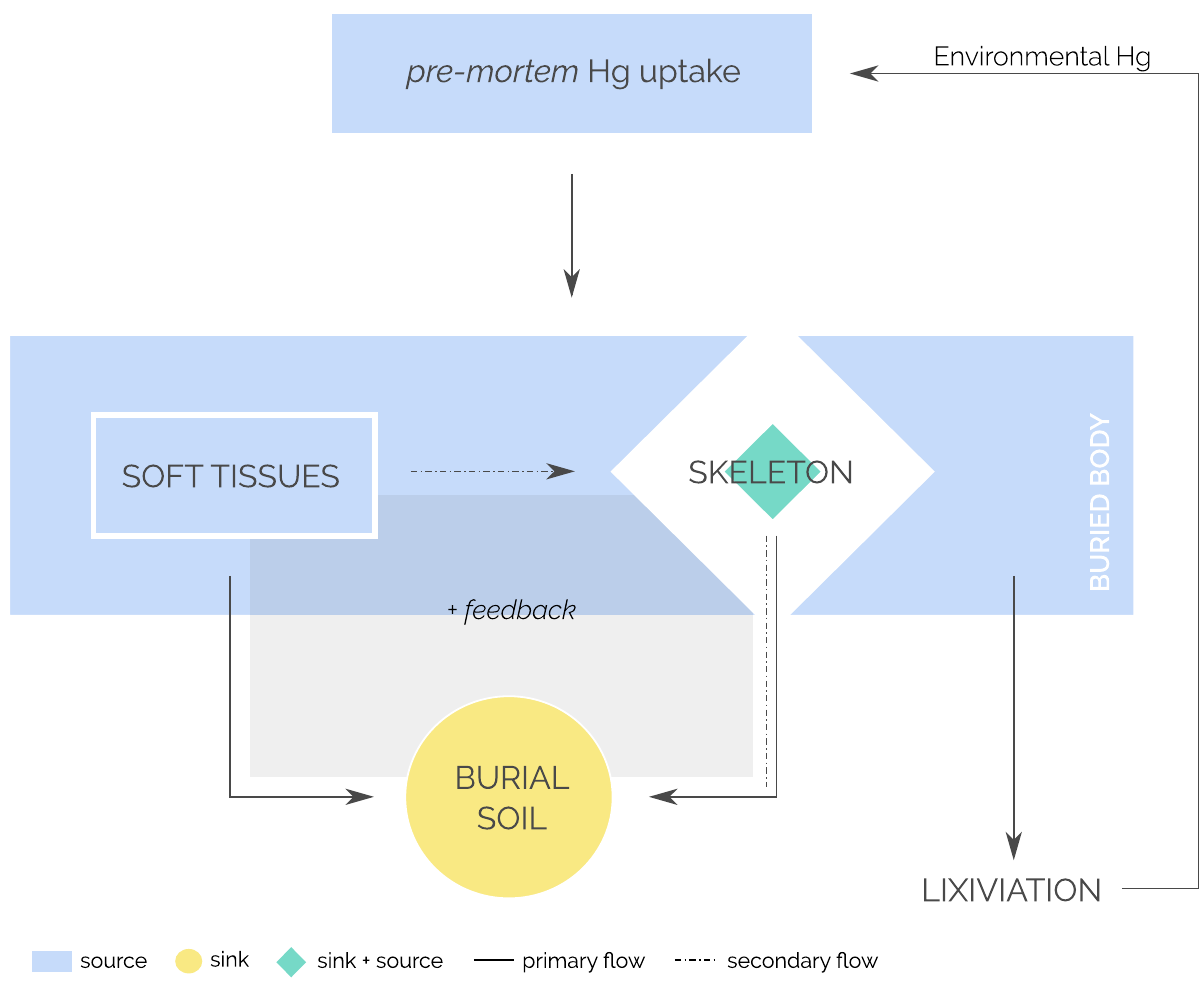
Figure 5. Mercury sink and sources from human exposure to burial/lixiviation in the soil through human body collected in the thoracic area of the three skeletons. The weight of LV3 tends to positive in samples of burial T5 while it does not show the same pattern in burial T1 (Fig. 1). This can be reflecting difference between burials. As already commented, the most important mercury target organs (kidneys, liver) are located close to the thoracic area 5 , which also contains the higher body mass—in comparison for example with the limbs or the head. Thus, differences in mercury content between soil close to thoracic area and soil close to the rest of the body would be expected. Furthermore, proteins forming the kidneys and liver start its putrefactive changes at early stages of body decomposition, while epidermis and muscles are more resistant to breakdown 49 . It is also likely that the higher content of Hg in this area is related with the higher availability during early body decomposition of both mercury and S compounds. Since the process takes place in the earliest stages of body decomposition the non- putrefied tissues would produce a confined environment and decrease mercury leaching. The negative loadings of P in this LV may also support this interpretation, as the soft tissue/bone ratio should also be higher in this body area and thus with lower net transfer of P to the soil. We speculate that “thoracic area” effect may be even more pronounced in graves with high mercury levels (i.e. periods with higher mercury levels of pollution and/ or individuals which suffered an acute intoxication, among other causes). As already commented, the model residuals showed no clear pattern (Fig. 3) and can reflect soil microscale heterogeneity. Diagenesis is of major concern when trace elements are studied in archaeological bones, as there is the poten- tial for the soil to be a source of elements for bones 30,55 . But works which assessed mercury diagenetic incorpora- tion into bone in archaeological burial environment 22,23,31,41,42 conclude that mercury bone levels were no related with diagenesis, unless the soils were naturally enriched in mercury. In a previous investigation in the same archaeological site we already reported very low mercury contents in soil (a pedo-sedimentary sequence produce an average of 0.9 ± 0.7 ng g −1 ) in comparison to bones of individuals of the same period as those of the present study (20.6 ± 23.5 ng g −1 ) 13 . Our PLSR model also supports the idea that the soil was not a significant source of Hg for buried bones. The situation seems to be rather the opposite; the buried individuals were most probably the source of the mercury accumulated in the soil (Fig. 5). In the particular case of our study, the decomposition of